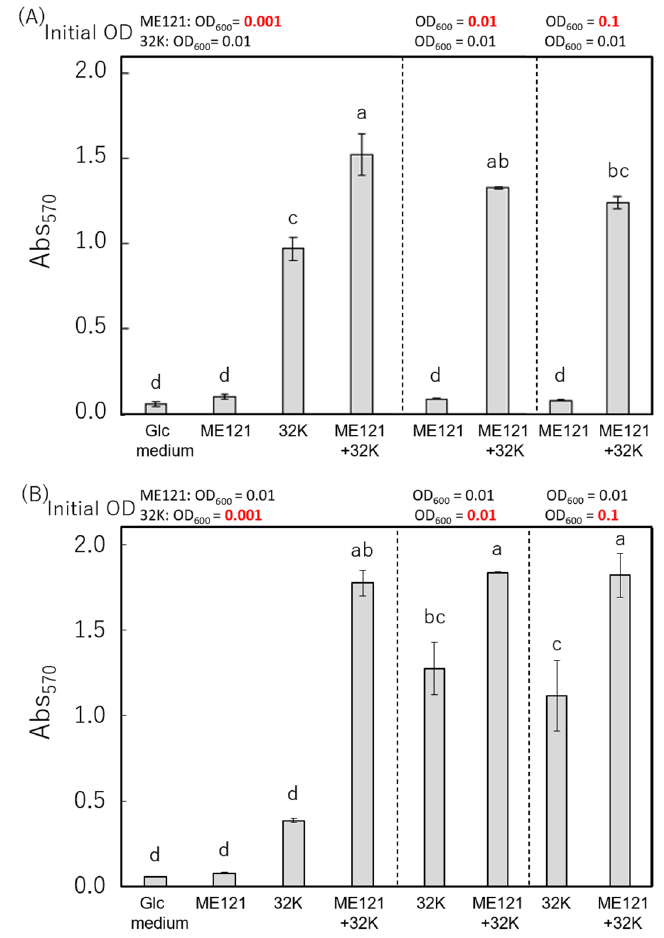
Figure 4. Biofilm formation in monocultures of strains ME121 and 32K, and coculture of strains ME121 and 32K when ( A ) the initial inoculum of strain ME121 was changed and ( B ) when the initial inoculum of strain 32K was changed. The vertical axis is Abs 570 , and the error bar is standard deviation. One-way ANOVA test was performed for equality of all means; ( A ): F (7, 39) = 140.00, p < 0.001, ( B ): F (7, 39) = 69.90, p < 0.001. Tukey’s test was performed for post hoc analysis, p < 0.05. Di ff erent superscript letters (a, b, c, d) denote significant di ff erences from each other in all combinations.